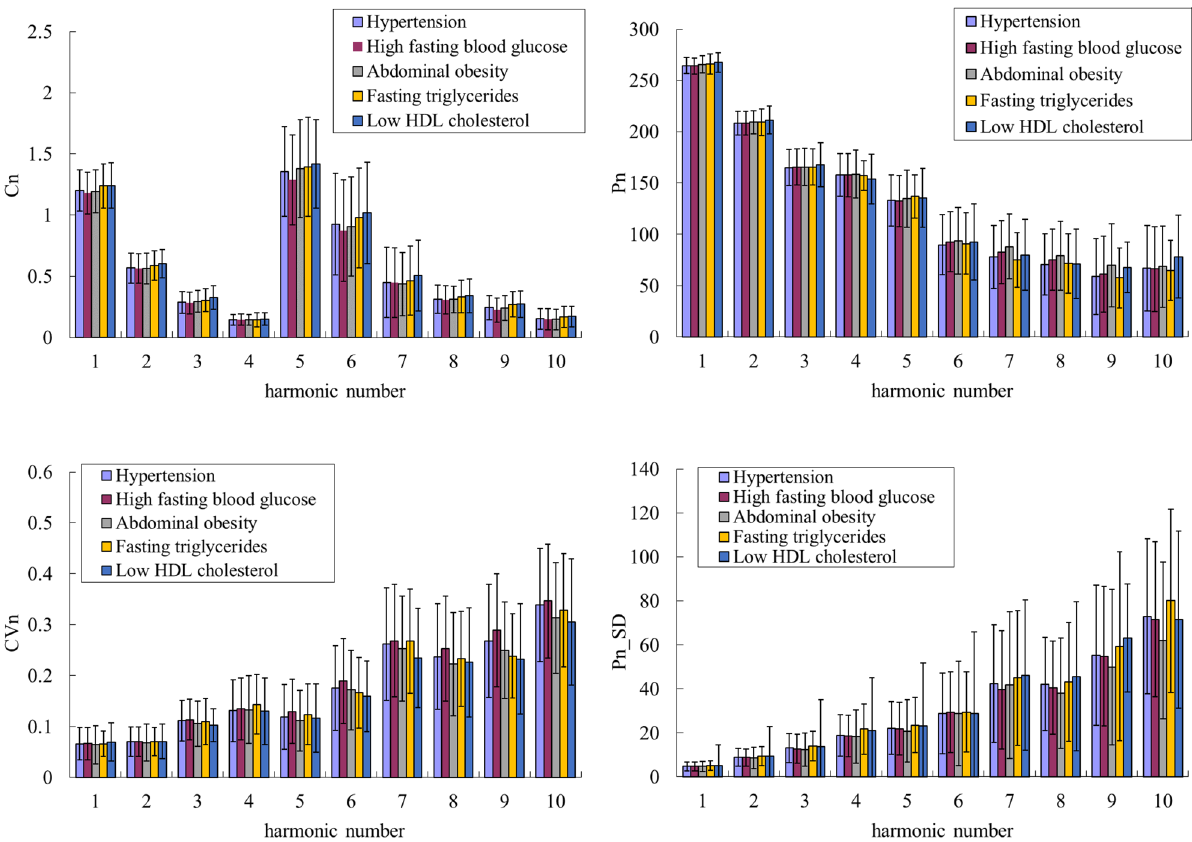
Figure 5. Comparisons of BPW harmonic indices in all subjects with MetS factors. C n , CV n , P n , and P n _ SD . Data are mean and SD values. C 5 – C 10 values have been multiplied by 10 to make the differences clearer. There were no any significant